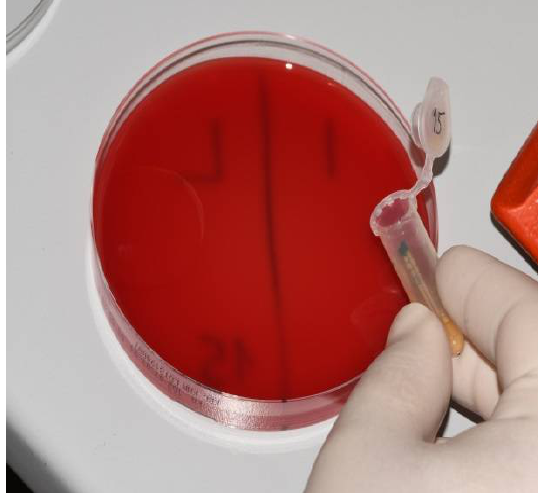
Figure 8. Application of the sample on to 5% blood agar.